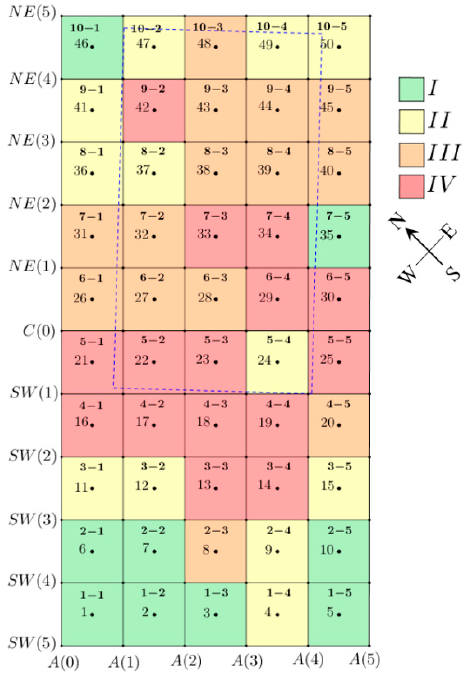
Figure 16. Visualization of sectors categorization (I: Δ H ≤ 1 m, II: Δ H ≤ 3 m, III: Δ H ≤ 6 m and IV: Δ H > 6 m).